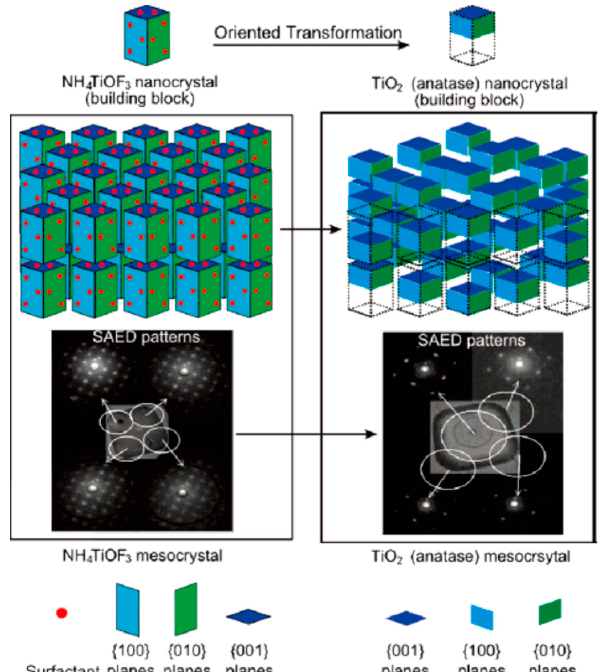
Figure 17. Illustration of the oriented transformation of NH 4 TiOF 3 mesophyte to TiO 2 (anatase) mesocrystal [71]. Copyright 2008 American Chemical Society.